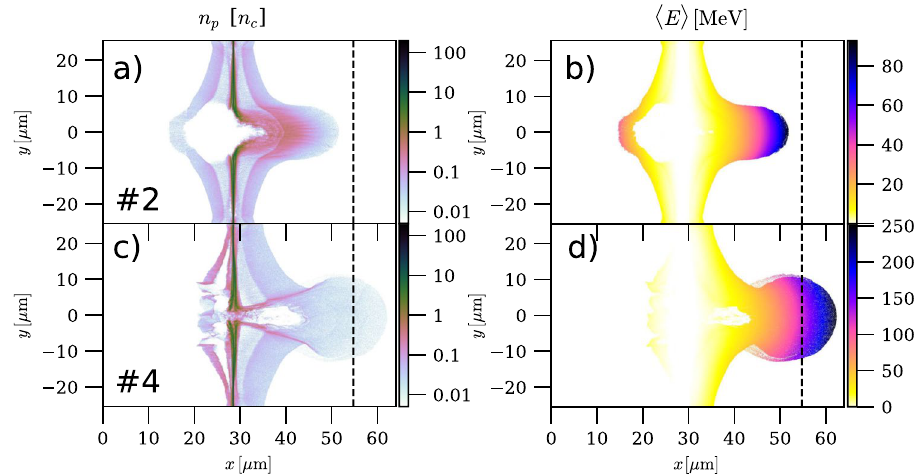
Figure 3. Visualisation of the proton acceleration process. Number density ( a , c ) and local average energy ( b , d ) of protons in runs #2 ( a , b ) and #4 ( c , d ), 207 fs after the laser pulse maximum has reached the solid foil. The dashed black line marks the position of the virtual detector where the quantities shown in Fig. 4 are measured.